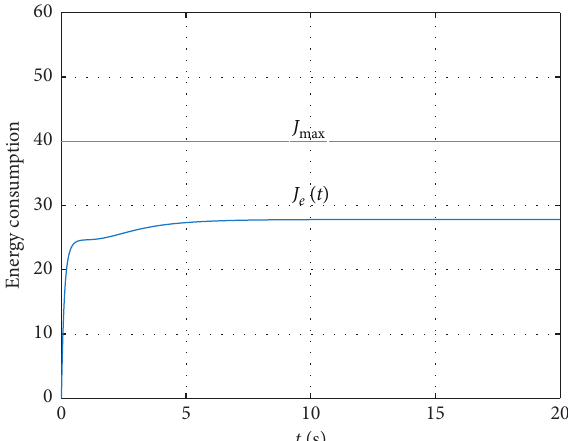
Figure 5: Energy consumption and the limited budget for time-varying formation tracking case.